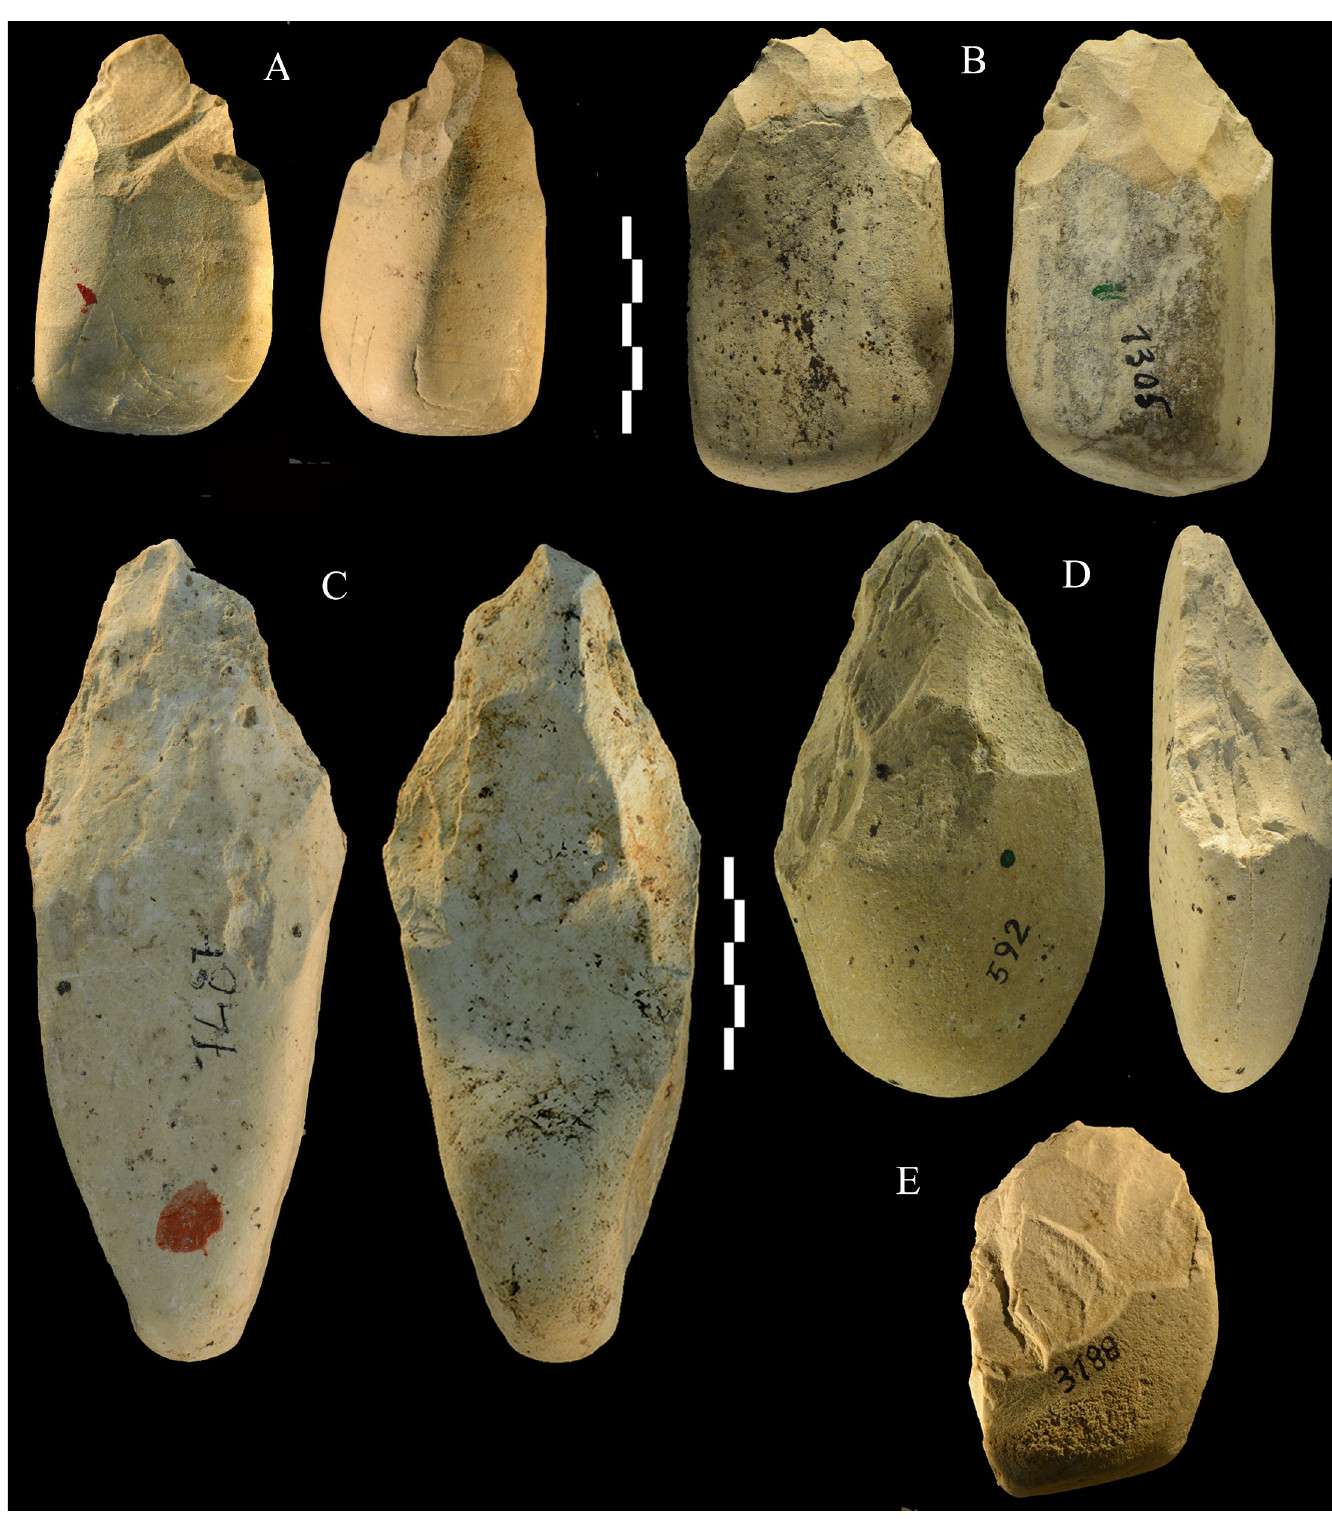
Fig 17. Castel di Guido lithics. Partial bifaces (A, B, C) and unifaces (D, E). A, B, E of chert, C and D of siltstone. Catalogue numbers 2398, 1305, 7487, 592, 3188. Scale bar 5 cm.